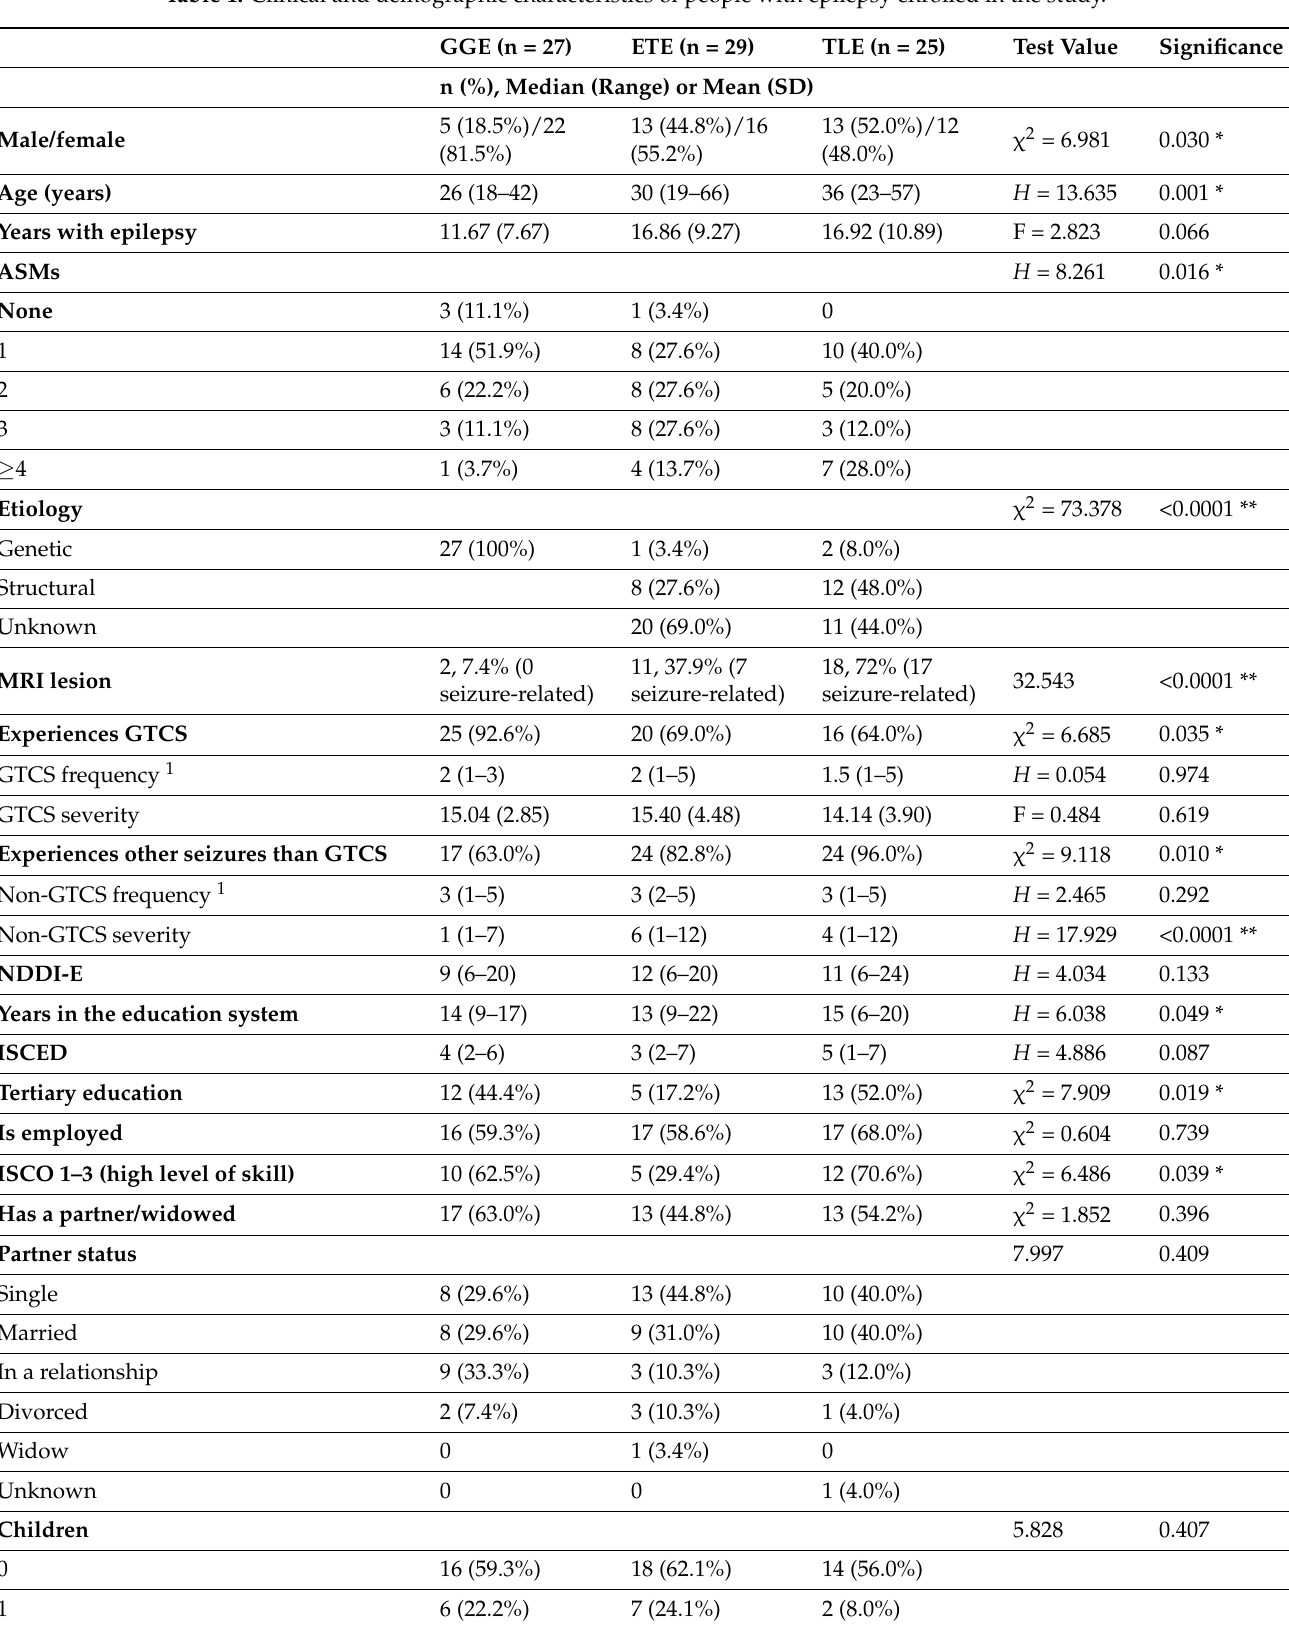
Table 1. Clinical and demographic characteristics of people with epilepsy enrolled in the